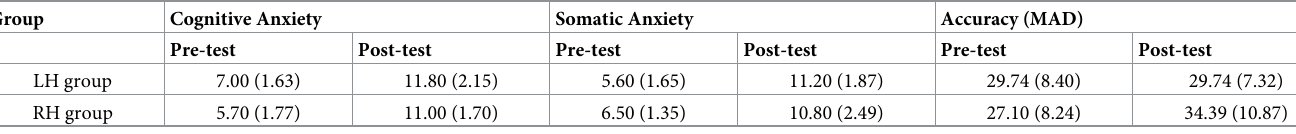
Table 1. Means and standard deviations for cognitive anxiety, somatic anxiety, and accuracy of valid serves.